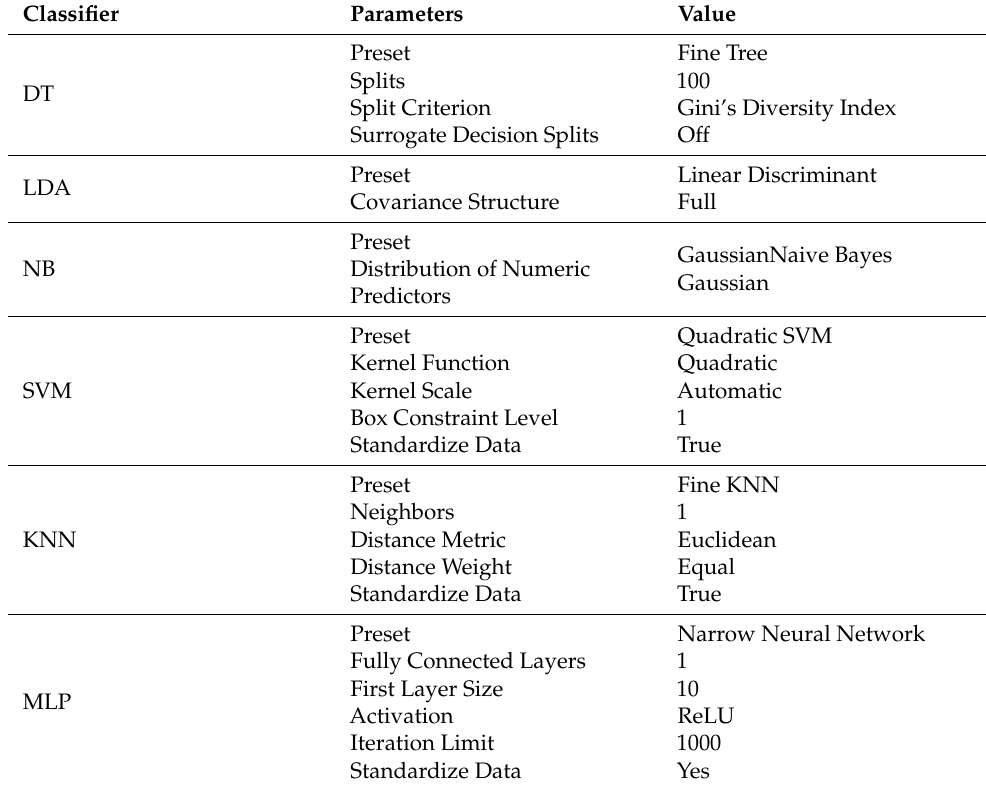
Table 1. Summary of parameters used to build the